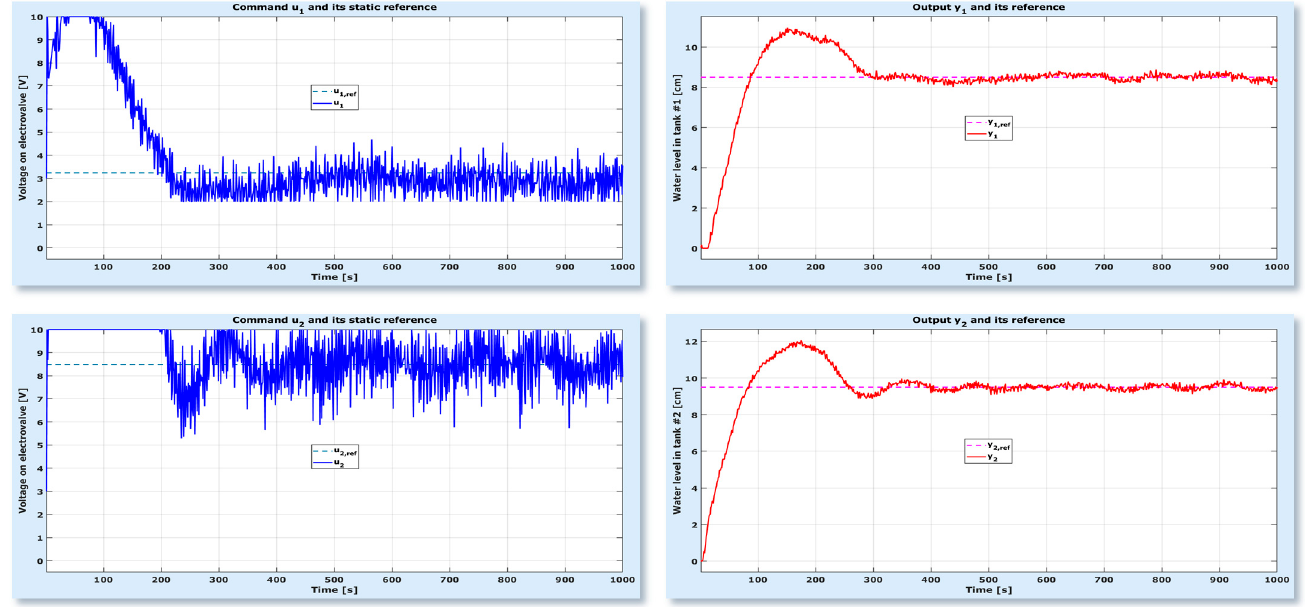
Figure 13. I/O signals for Ziegler–Nichols tuned PID-R controller, in case of <raw> idmo, %.